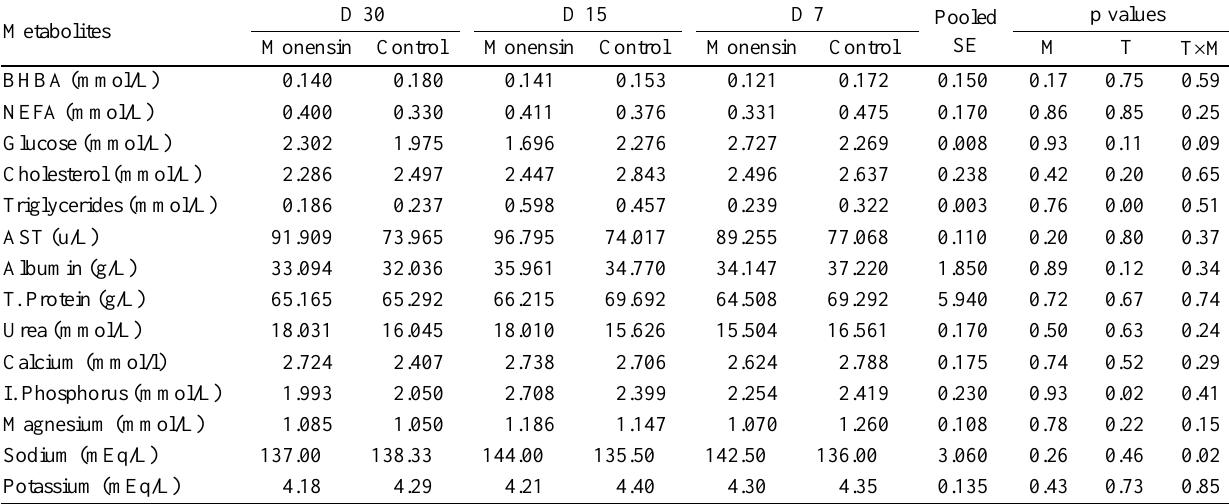
Table 3. Comparison of least square of means (LSMs) and standard errors (SEs) of serum constituents among pregnant Saanen goats receiving monensin and Controls not fed monensin during the pre-parturition period (within 30 d before parturition) 1